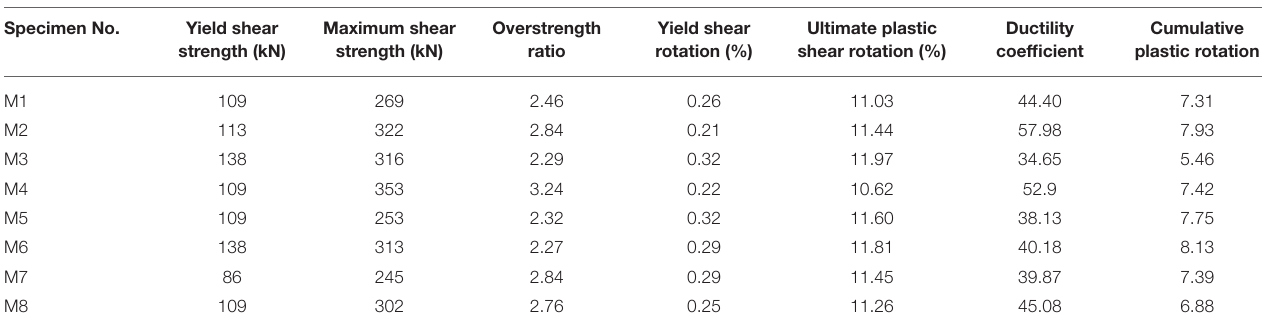
TABLE 4 | Shear strength and deformation capacity of metallic dampers. Specimen